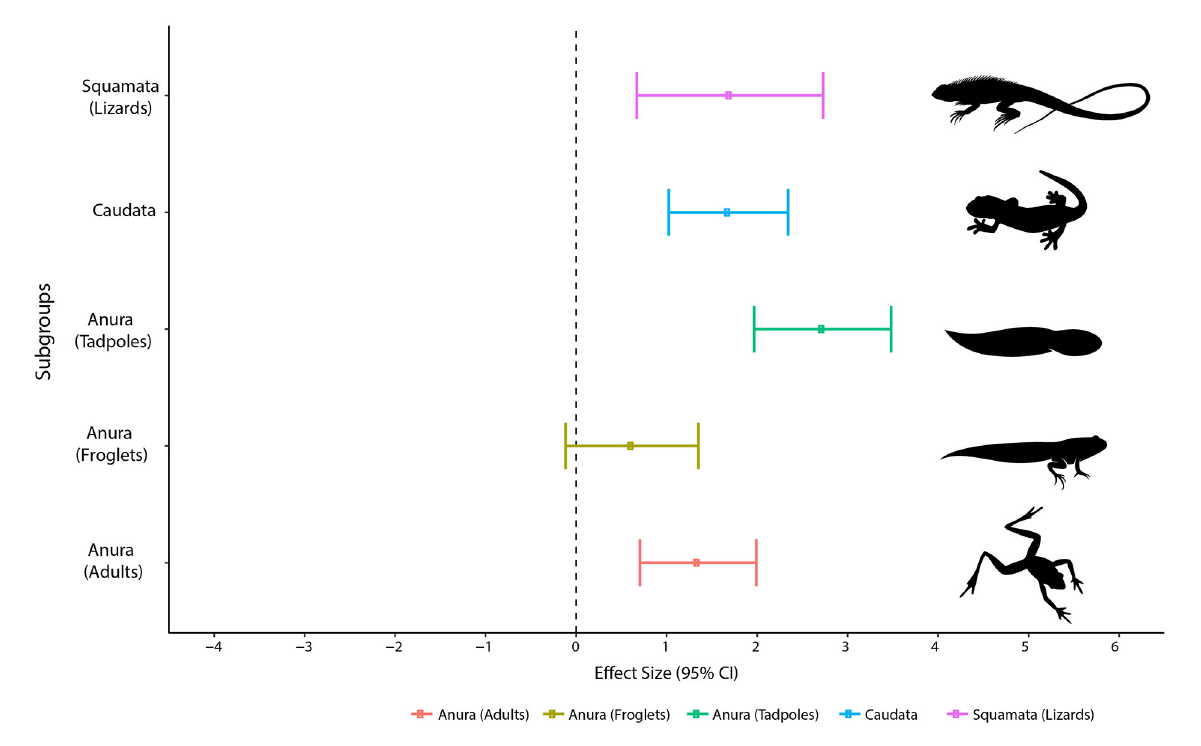
FIGURE2 Effect size values measuring the influence of acclimation on the CTMax of Squamata (Lizards), Caudata and Anura (Tadpoles; Froglets; and